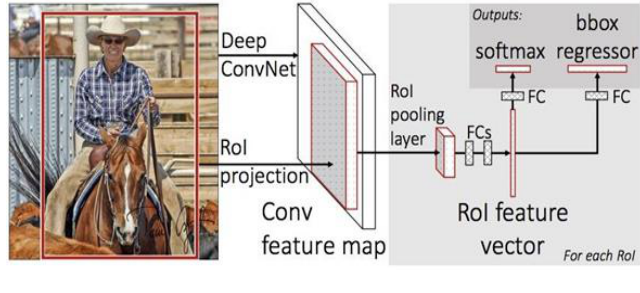
Figure 2. Fast R-CNN